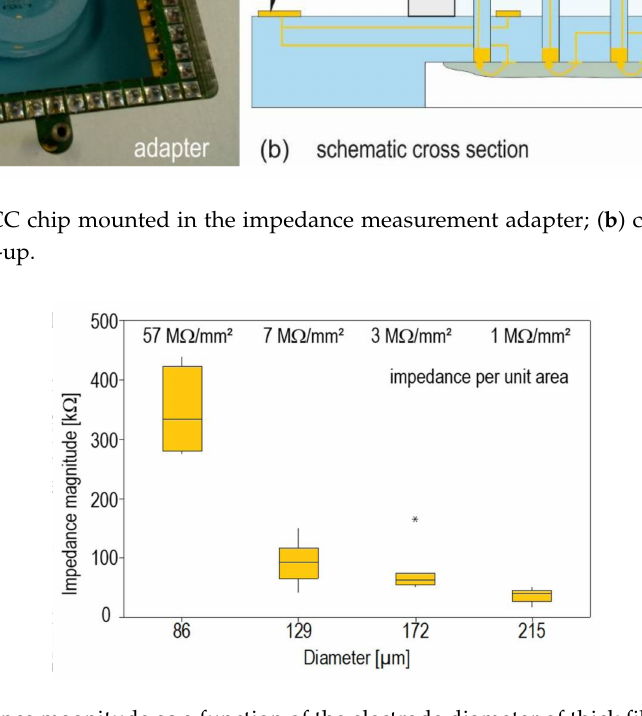
Figure 4. Impedance magnitude as a function of the electrode diameter of thick film gold electrodes, measured at a frequency of 1 kHz (Type B